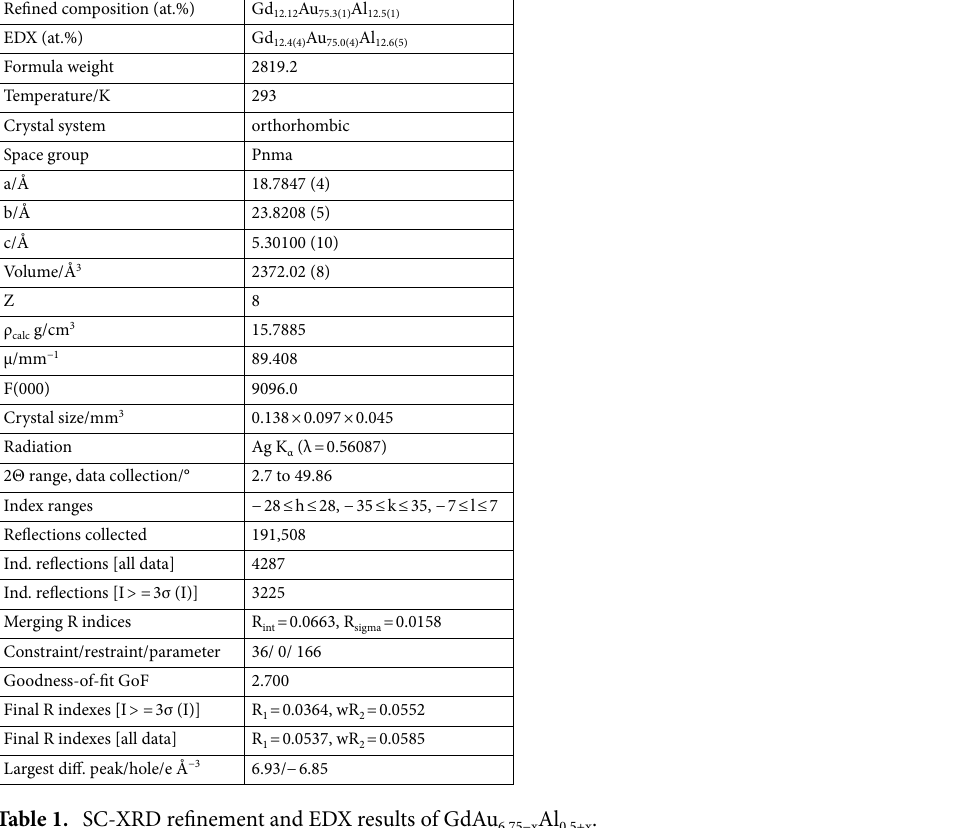
Table 1. SC-XRD refinement and EDX results of GdAu 6.75−x Al 0.5+x